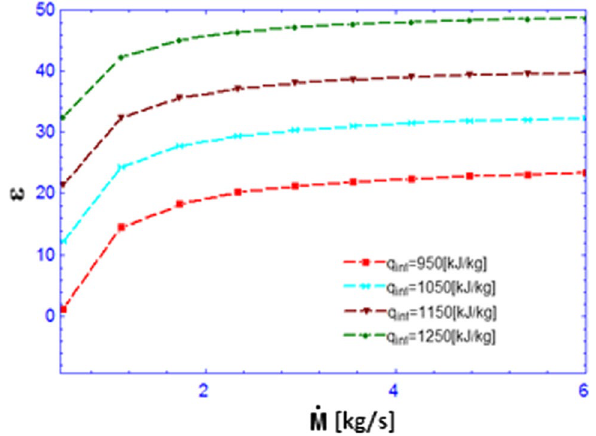
Fig. 12 Efficiency of Rankine cycle versus mass flow rate of the reverse osmosis at different thermal heat levels